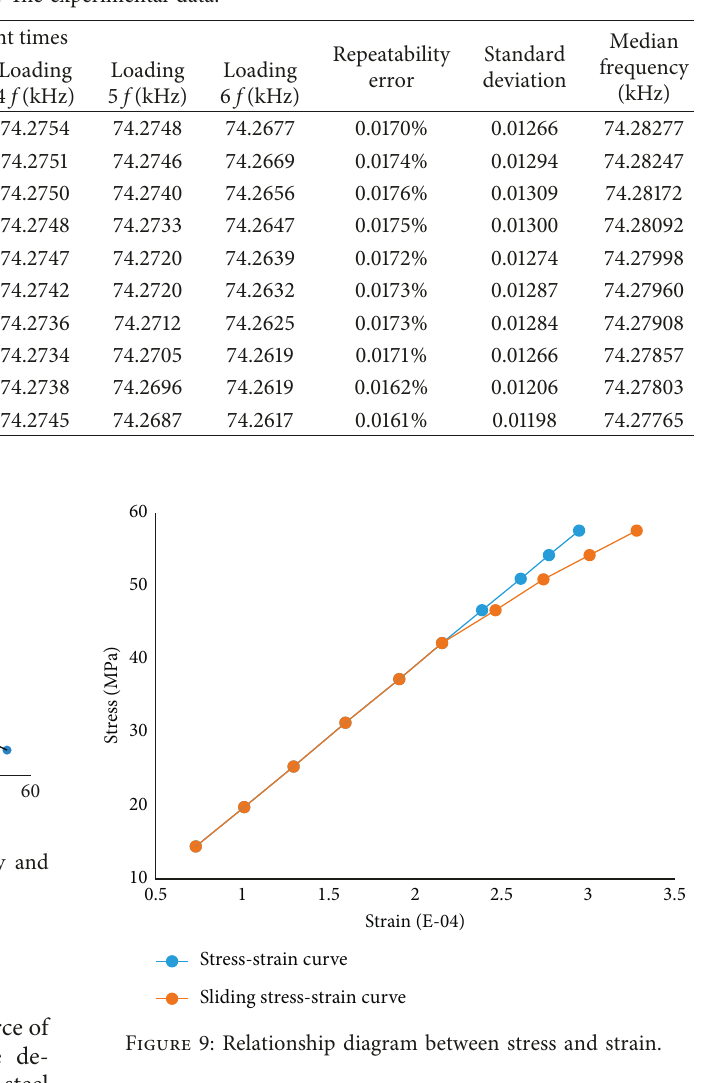
Table 2: The experimental